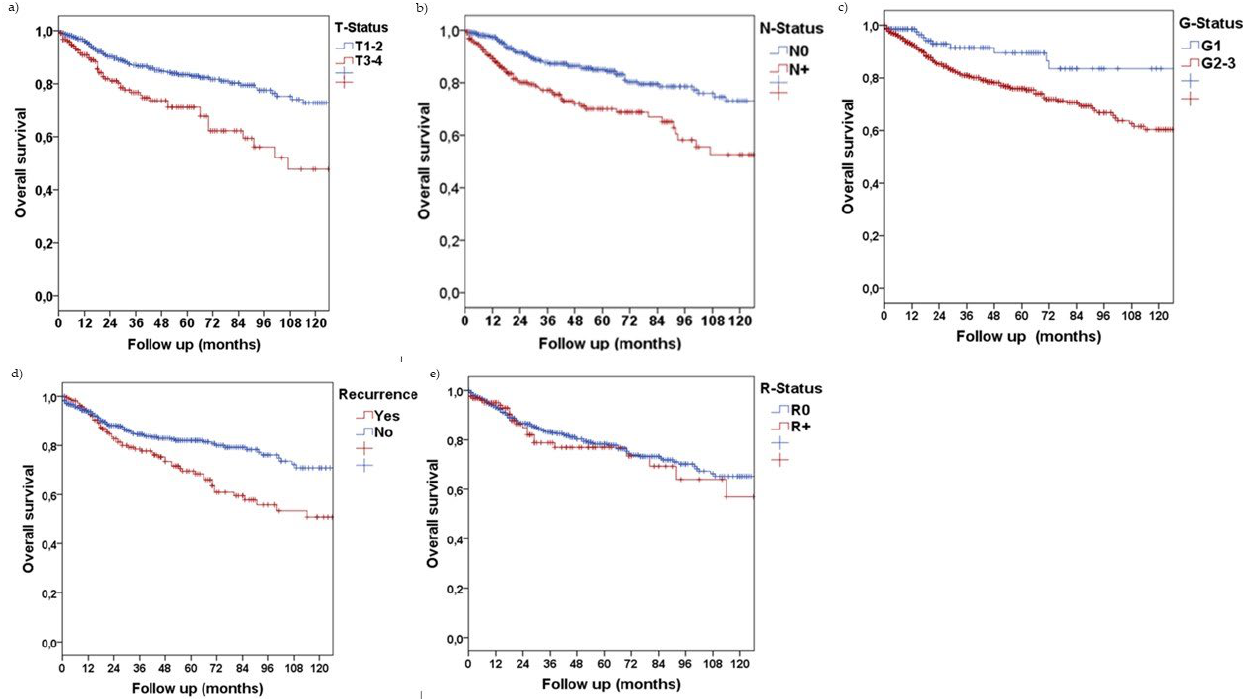
Figure 2. 10-year overall survival Kaplan–Meier curves for ( a ) tumor size, ( b ) lymph node status, ( c ) histopathological grading, ( d ) recurrence, ( e ) resection